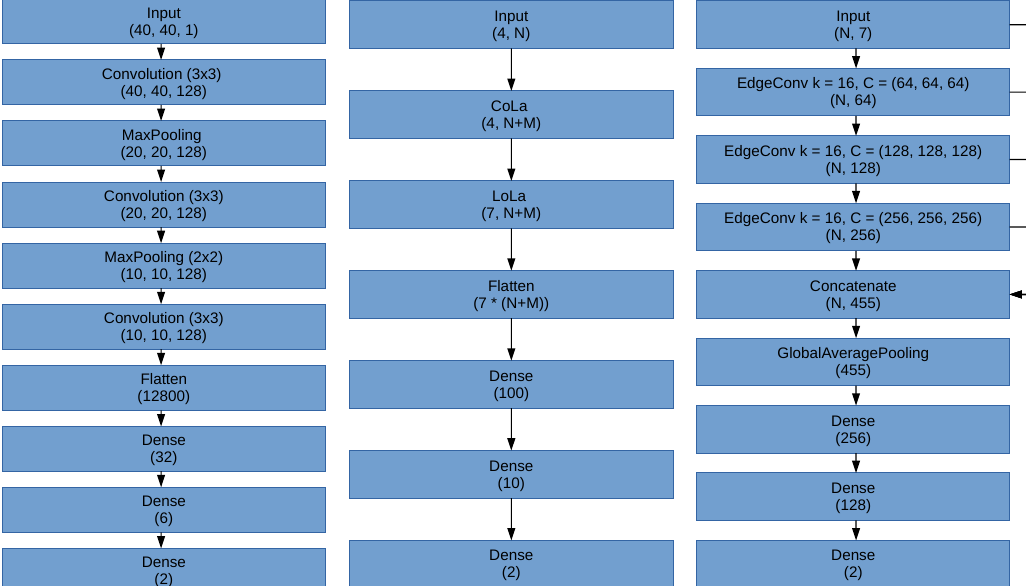
Figure 9: Sketch of the CNN architecture for jet image classification (left panel), the LoLa architecture for classification on four-vectors (middle panel) and for the DGCNN architecture for classification on particle clouds (right panel). Each block corresponds to one layer in the network. The first line of each block describes the kind of layer and the kernel size, if applicable. The first line in the blocks for EdgeConv layers give the number of nearest neighbours k and the number of filters used in the three convolutions C. The second line states the output dimension of each layer, with N the number of jet constituents used, and M the number of added linear combinations in the LoLa